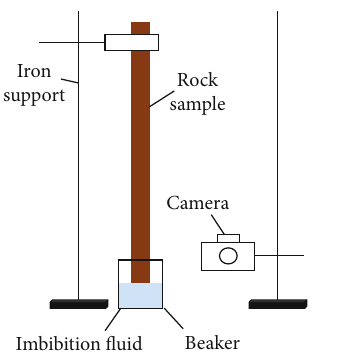
Figure 1: Flow chart of improved imbibition height experiment.